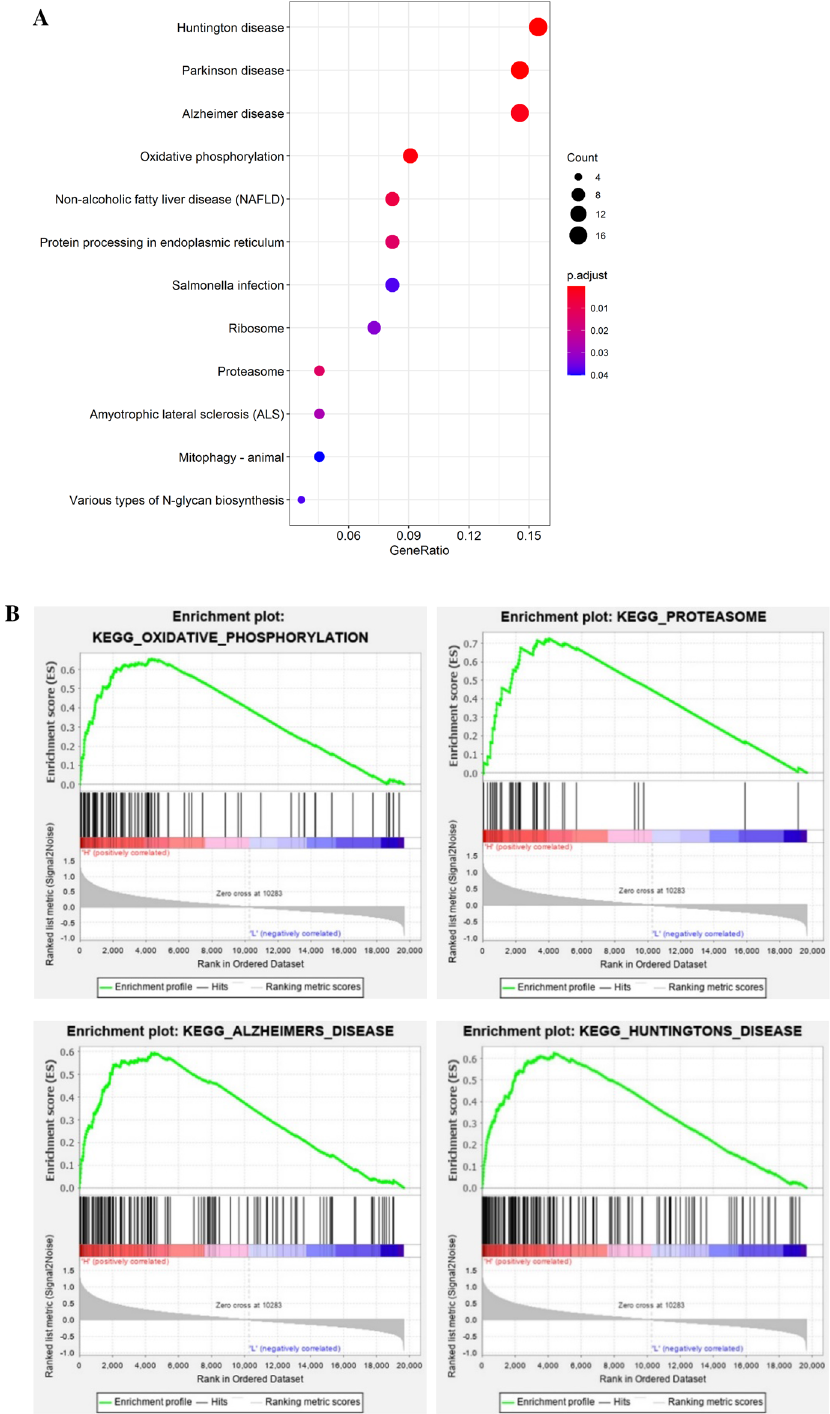
Figure 7. KEGG pathways related to intervertebral disc degeneration in the hub modules intersected with gene set enrichment analysis of CD63. ( A ) KEGG pathways significantly enriched in 12 signaling pathways. ( B ) 4 hub pathways were finally obtained when intersected KEGG pathways with gene set enrichment analysis of